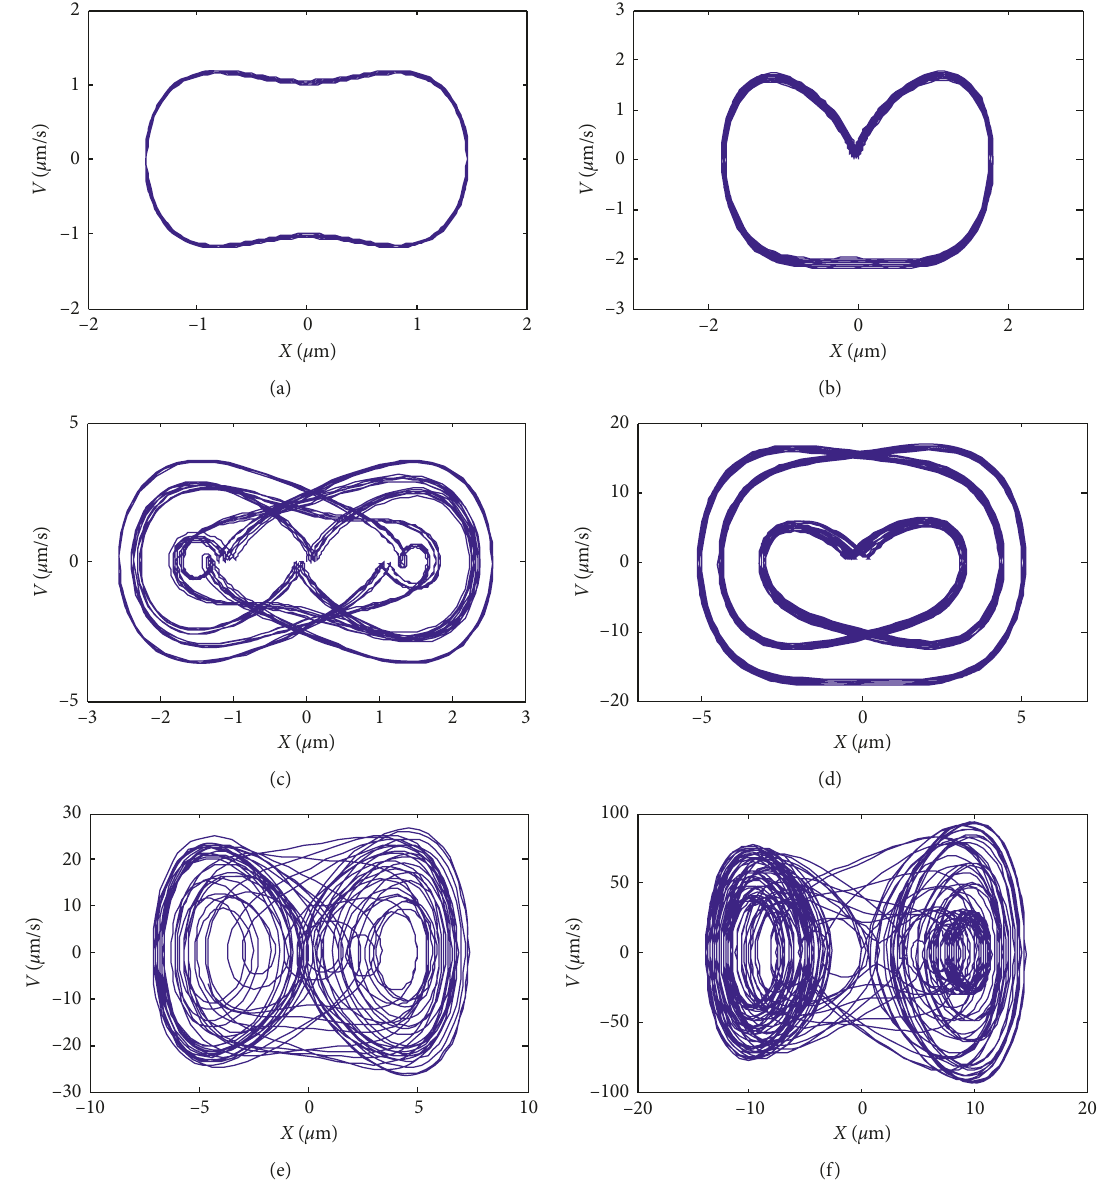
Figure 7: Phase diagram. (a) P � 20, (b) P � 100, (c) P � 260, (d) P � 450, (e) P � 600, and (f) P �